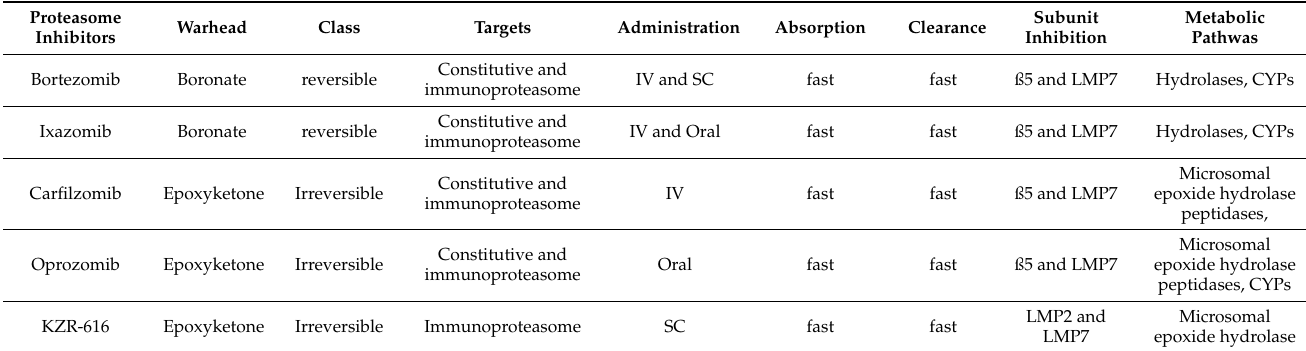
Table 1. Properties of proteasome inhibitors and their clinical